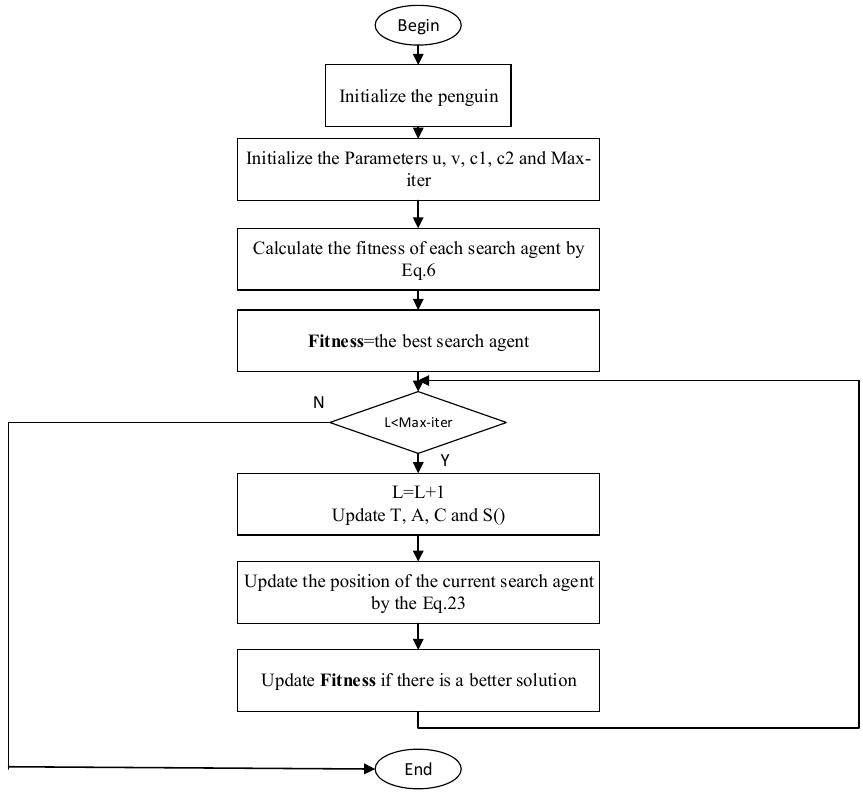
Figure 6. The flowchart of the HSOA.